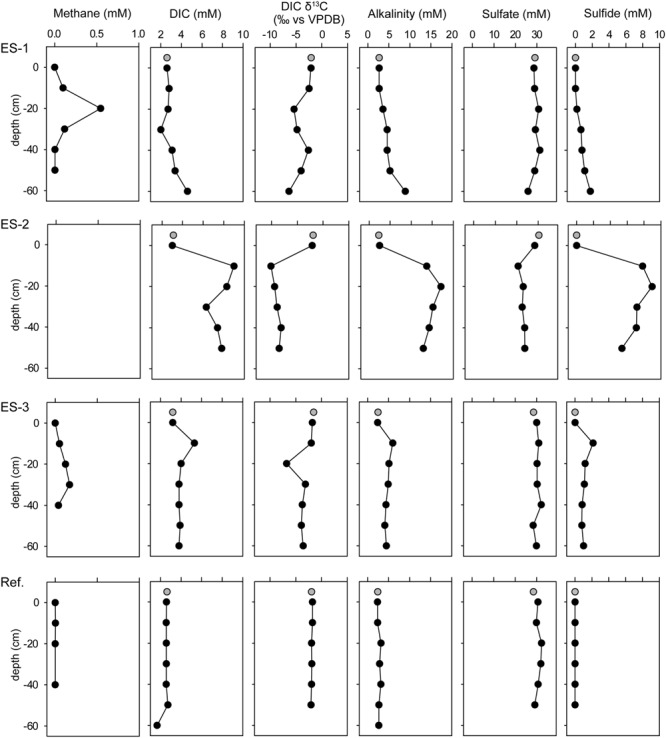
Concentration profiles of methane, dissolved inorganic carbon (DIC), DIC isotopic signature (vs. VPDB), alkalinity, sulfate, and sulfide of the three investigated emission spots: ES1a, ES2, and ES3, as well as a reference spot (Ref). Gray circles show water column measurements from 50 cm above seafloor.